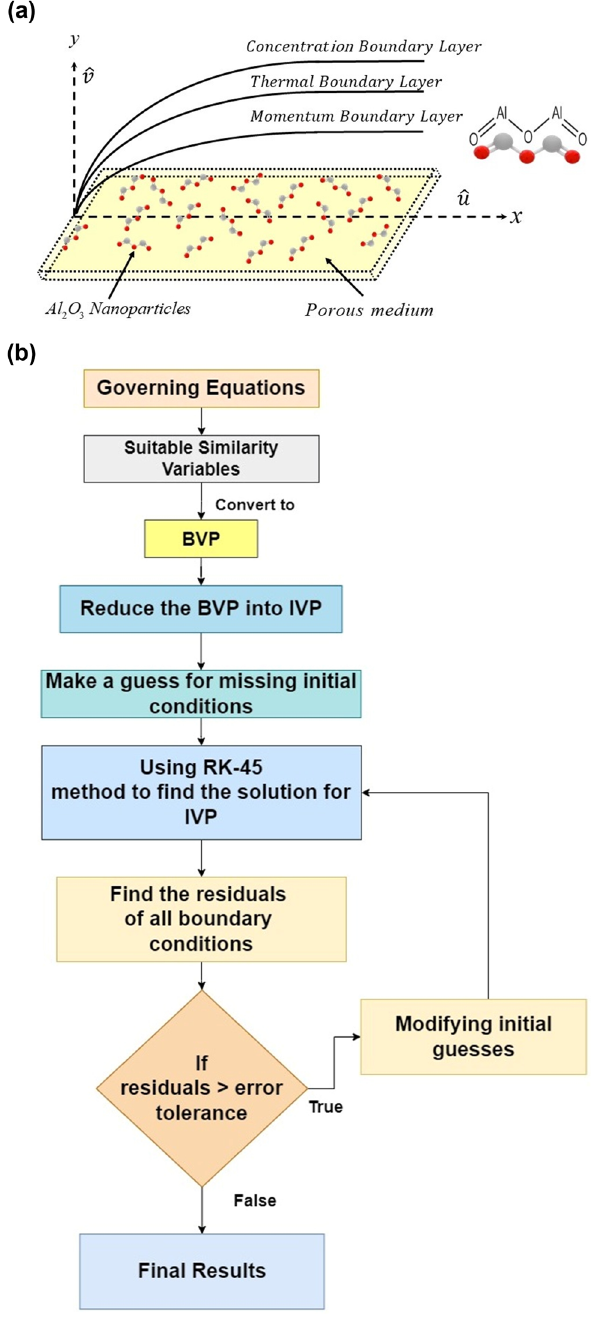
Figure 1: ( a ) Geometry of the fl ow problem. ( b ) Algorithm of the fl ow